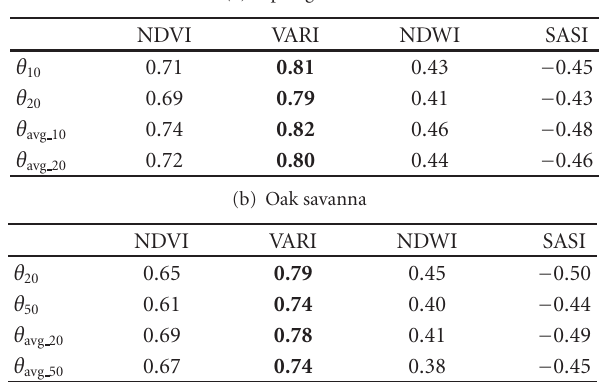
Table 2: Correlation coe ffi cients ( r ) between NDVI, VARI, NDWI, SASI, and instantaneous volumetric soil moisture ( θ 10 and θ 20 ) and 16-day average soil moisture ( θ avg 10 and θ avg 20 ) in the open grassland (a) and oak savanna